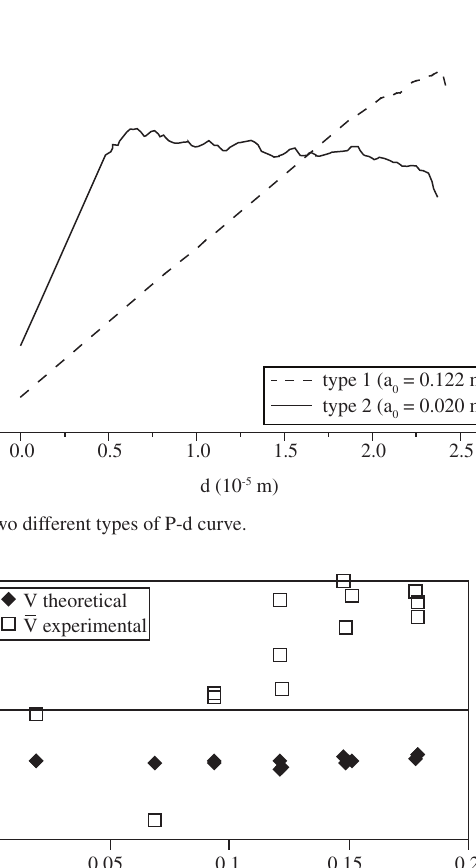
Figure 10. Average velocity of crack propagation, V, vs. a